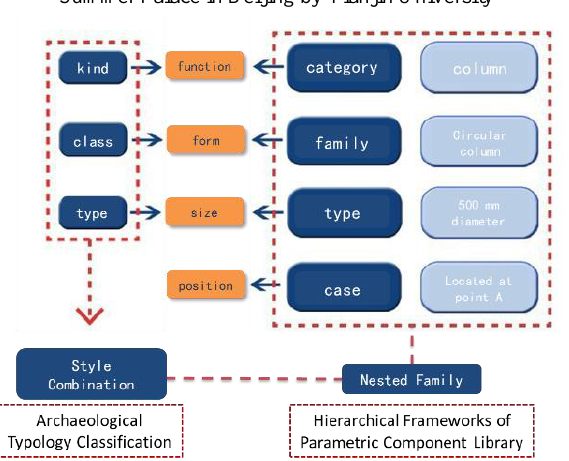
Figure.3 hierarchical frameworks of parametric component library & archaeological typology classification